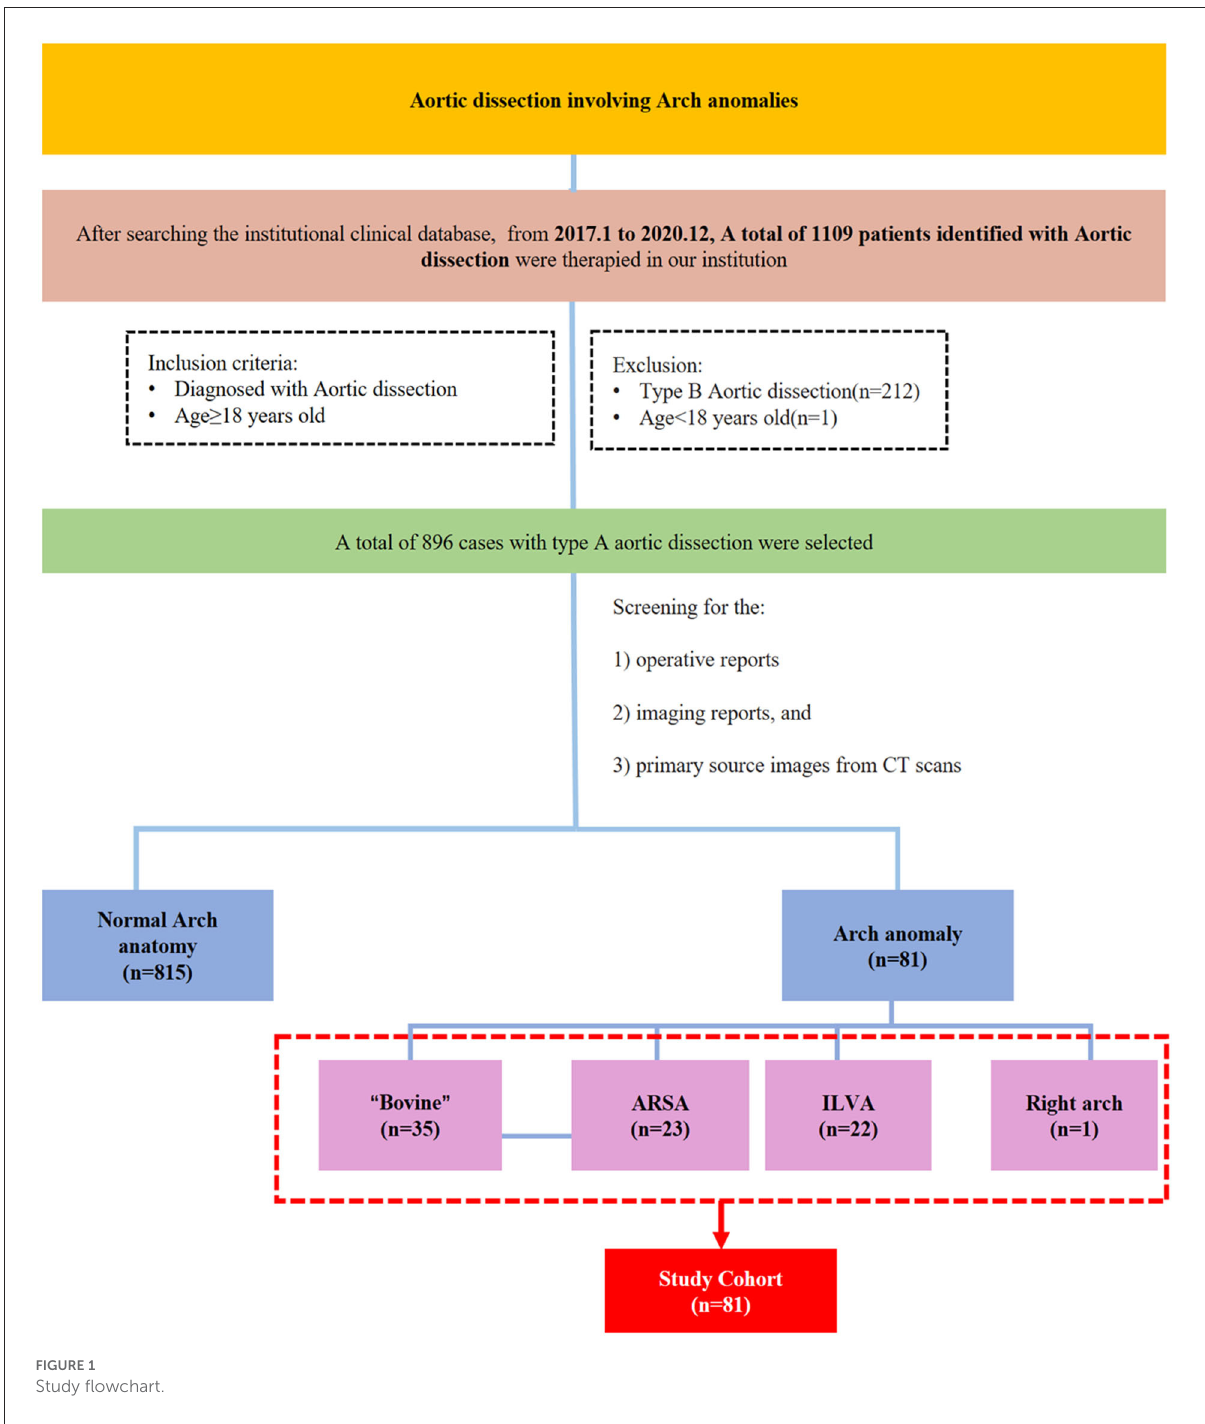
carotid artery (LCCA), or the LCCA originating directly from the IA; (2) aberrant right subclavian artery (ARSA): a four- vessel arch with an aberrant right subclavian artery originating from the distal arch or proximal descending aorta; (3) isolated left vertebral artery (ILVA): a four-vessel arch with the left